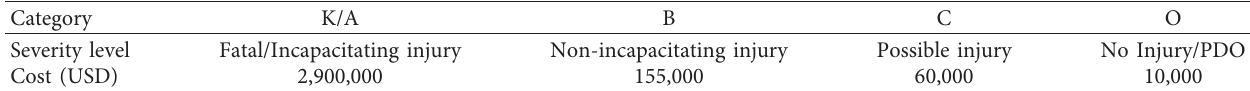
Table 2: Crash severity levels and costs in Washington state,